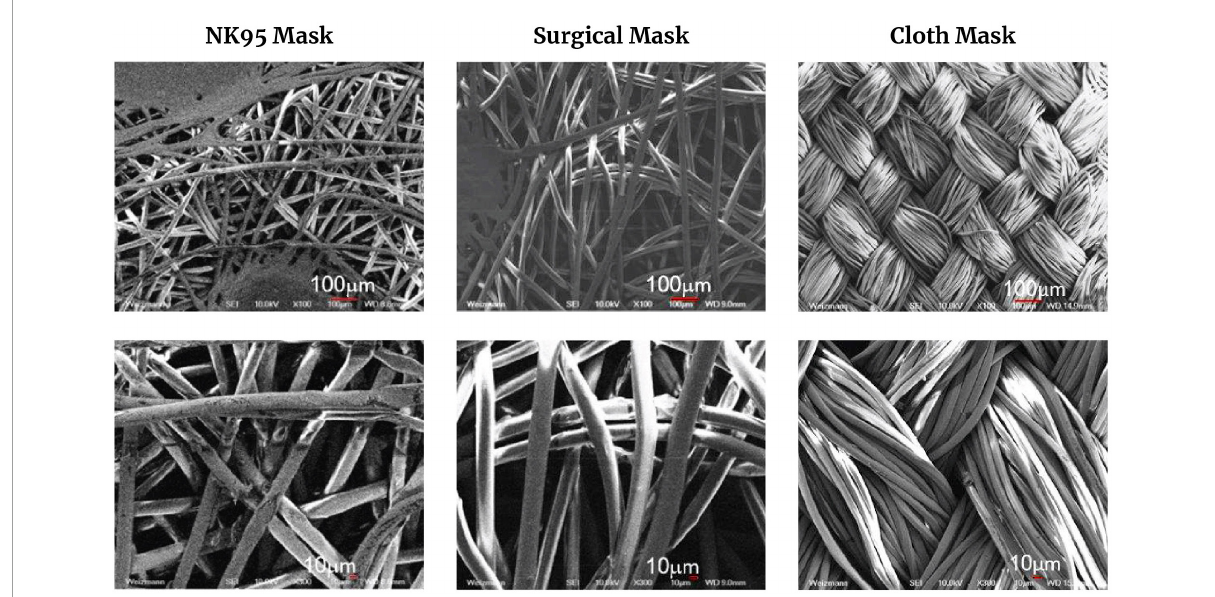
FIGURE1 Example of question from unit on “Good health and well-being” (SDG 3). Question and accompanying illustrations of three main types of masks on the market for public use, taken from a Scanning Electron Microscope (SEM) and depicting the surface of the masks on the micrometer scale.